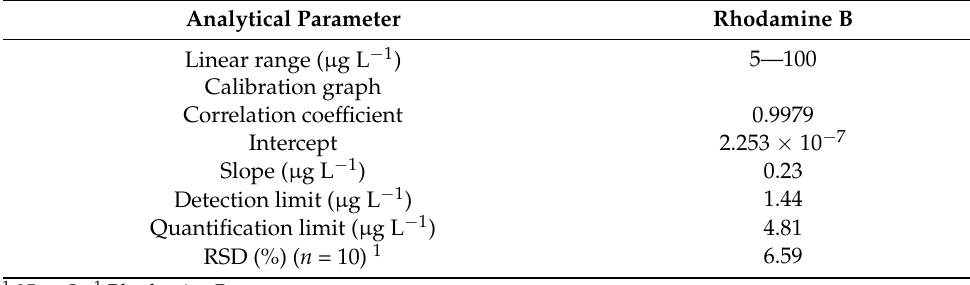
Table 3. Analytical parameters obtained for the Rhodamine B determination.